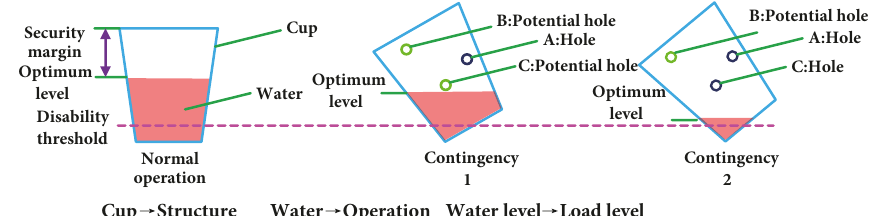
Figure 2: An example to explain the electrical